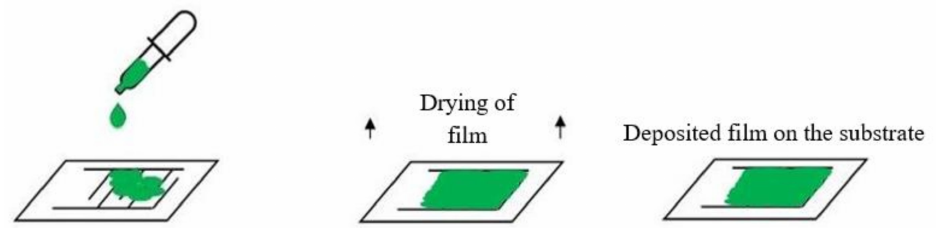
Figure 11. Schematic diagram of drop-casting technique.